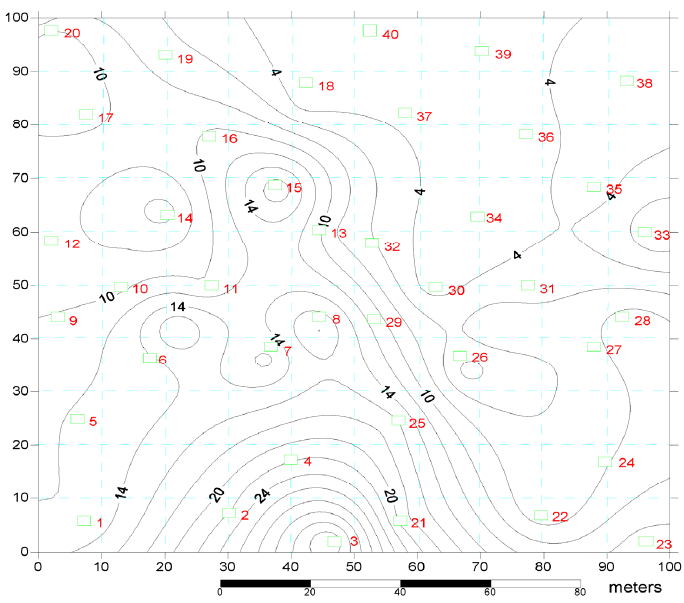
Figure 2. Distribution of measuring points and relative height in experiment Site.